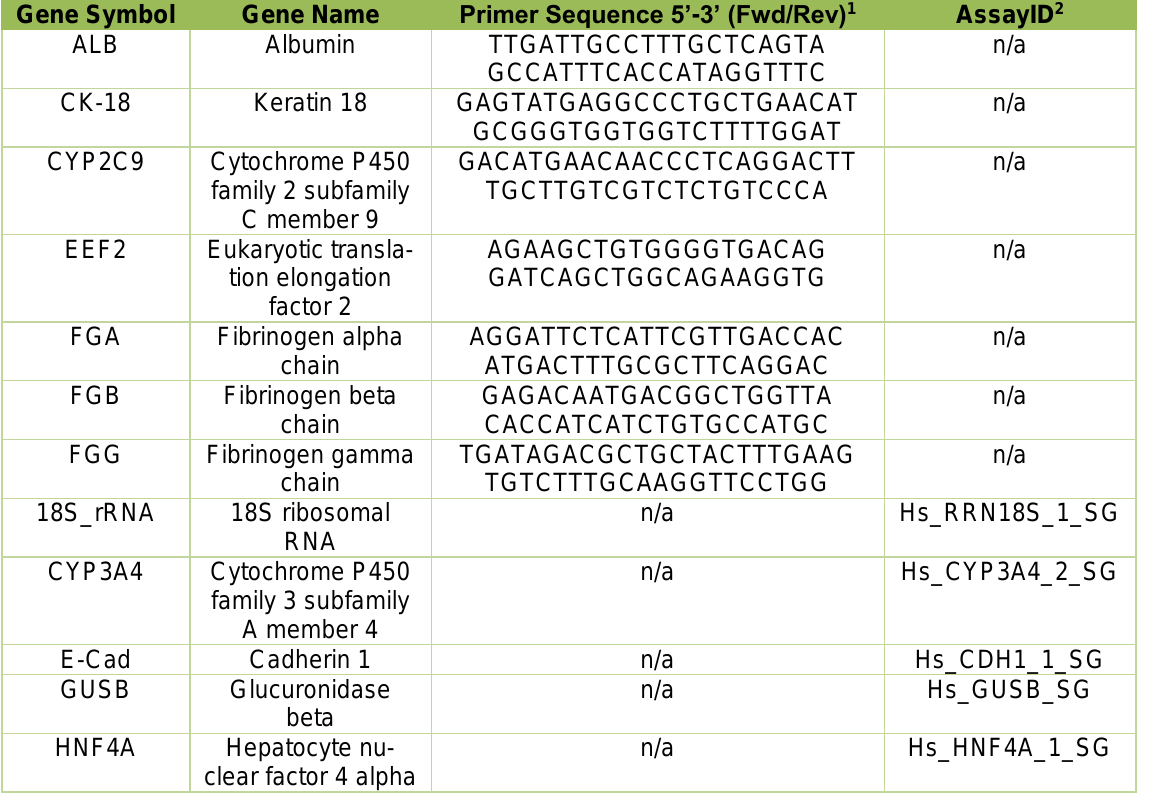
Table 3: Primers utilized for RT-qPCR Gene Symbol